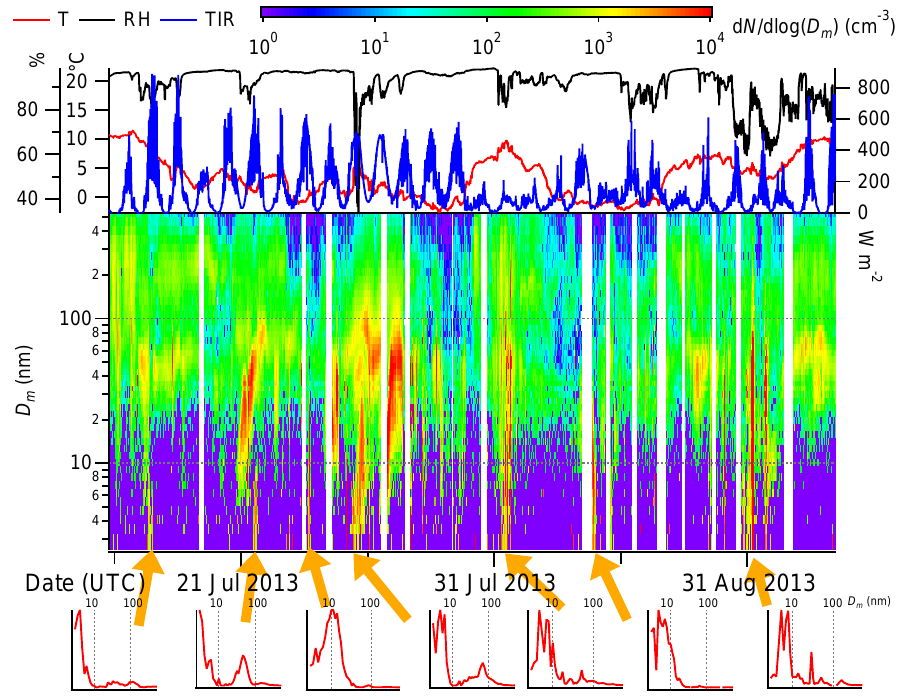
Figure 2. Temperature ( T ), relative humidity (RH) and total incident radiation (TIR) during the cruise, with DMPS size-resolved number concentration plotted data against electrical mobility diameter ( D m ) . White areas on the plot denote instrument downtime or when it was otherwise not sampling ambient air. Distributions from the seven candidate events in Fig. 1 are shown below to illustrate the shapes of the distributions during these events. Axis labels have been omitted for clarity, but are the same as the plot above, i.e. d N/ dlog (D m ) (cm − 3 ) vs. D m